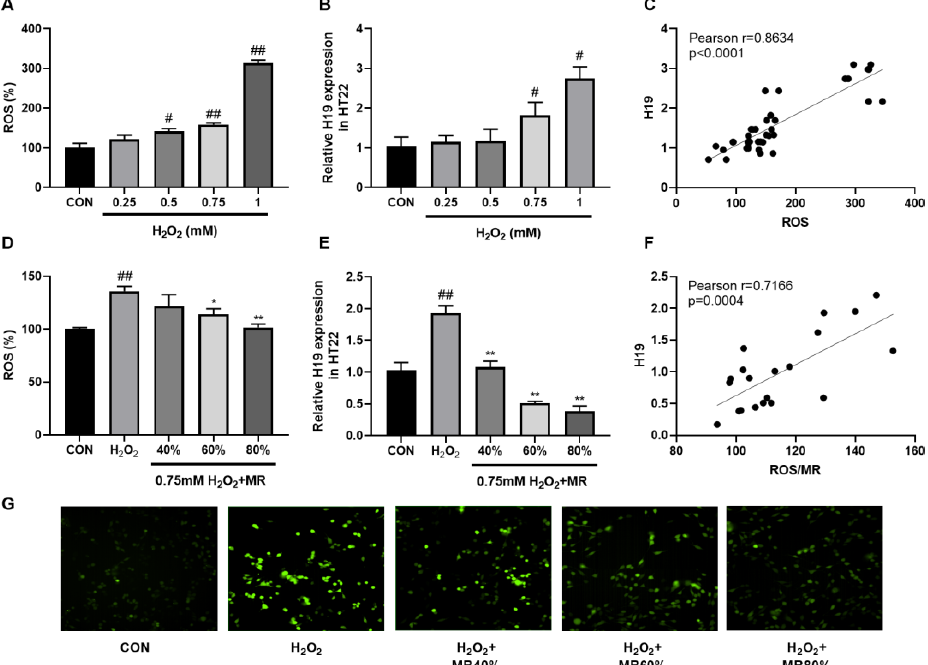
Figure 6. Effects of MR on the high expression of H19 induced by ROS in HT22 cells. ( A ) Relative ROS levels induced by different concentrations of H 2 O 2 in HT22 cells. ( B ) Relative H19 expression in HT22 cells treated with different concentrations of H 2 O 2 . ( C ) Pearson correlation between H19 and ROS in HT22 cells treated with different concentrations of H 2 O 2 . ( D ) Relative ROS levels in HT22 cells treated with H 2 O 2 (0.75 mM) and different levels of MR. ( E ) Relative expression of H19 in HT22 cells treated with H 2 O 2 (0.75 mM) and different levels of MR. ( F ) Pearson correlation between H19 and ROS in HT22 cells treated with H 2 O 2 (0.75 mM) and different levels of MR. ( G ) DCFH fluorescence in HT22 cells treated with H 2 O 2 (0.75 mM) and different levels of MR. All data are shown as the mean ± SEM. # p < 0.05, ## p < 0.01 (vs. CON); * p < 0.05, ** p < 0.01 (vs. H 2 O 2 ). Flow cytometry was used to quantify the level of apoptosis. As shown in Figure 7E,G, HG (225mM) significantly increased the apoptosis of HT22 cell compared to the CON group ( p < 0.01). Compared with the HG group, MR significantly inhibited apoptosis in a gradient-dependent manner even at high glucose concentrations with apoptosis rates of about 60% ( p < 0.01).